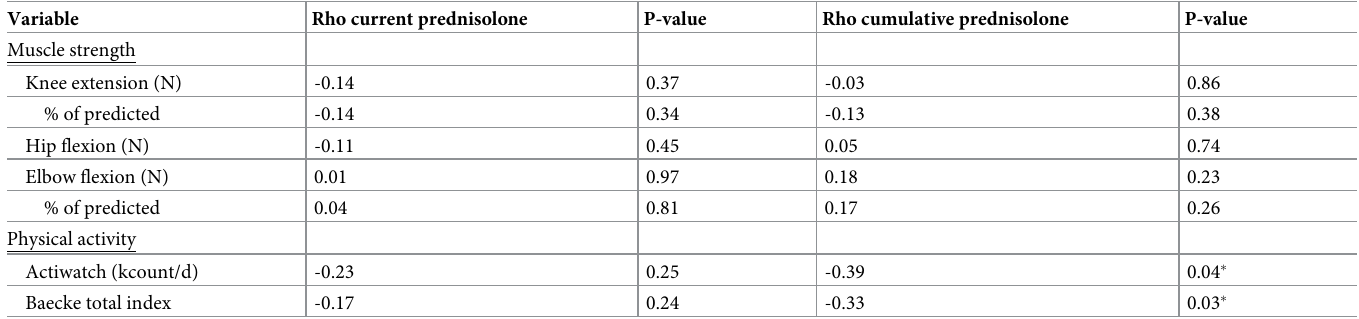
Table 4. Correlation of muscle strength and physical activity with prednisolone use.